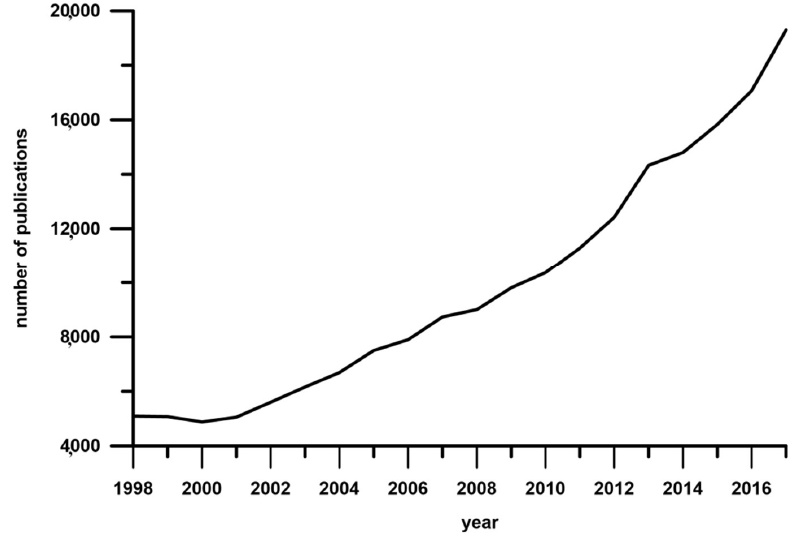
Figure 1. Evolution in the number of papers with the keyword “phenolic compounds” (Science direct, June 2018).